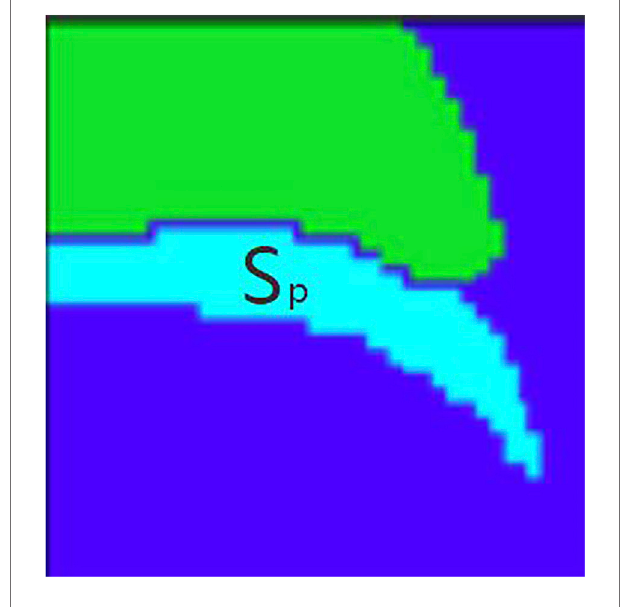
FIGURE 5 | Barium meal area S